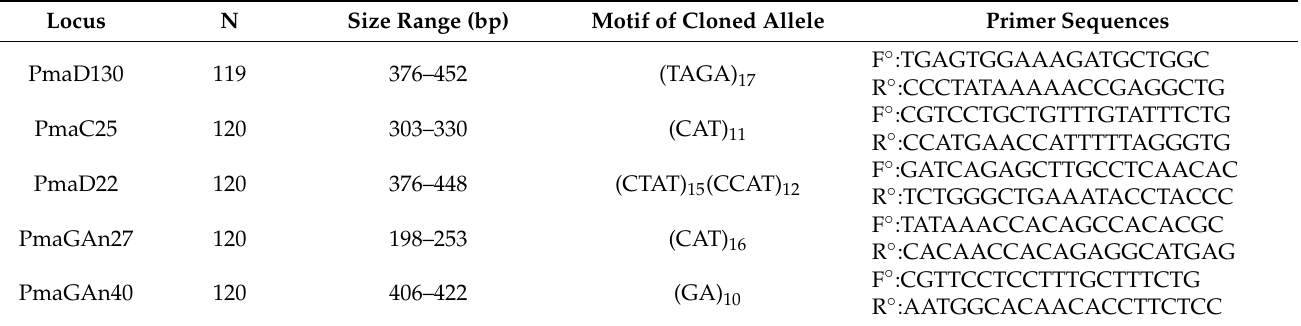
Table 1. Summary of seven microsatellite loci characteristics for the great tits, including number of individuals (N), allele size ranges, motif of cloned alleles, and primer